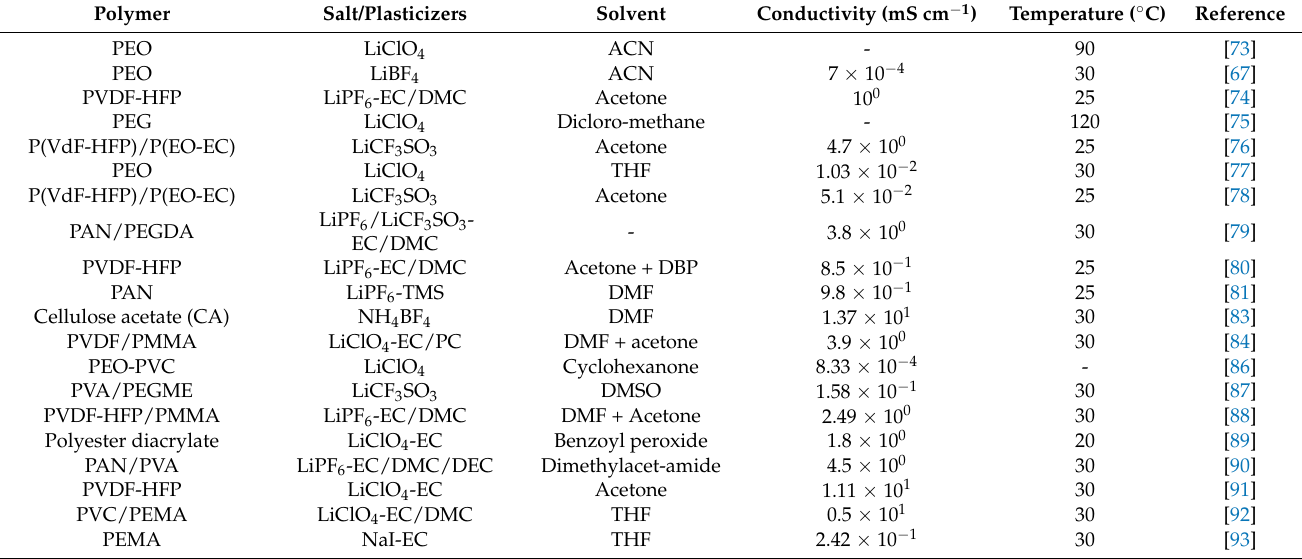
Table 1. List of GPEs with TiO 2 filler with their conductivity and temperature.